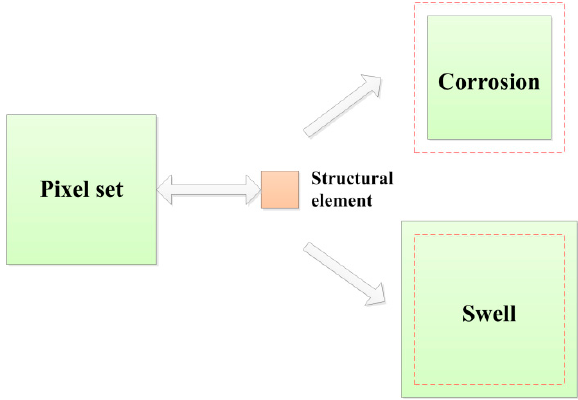
Figure 1. The corrosion and swell of the morphology.